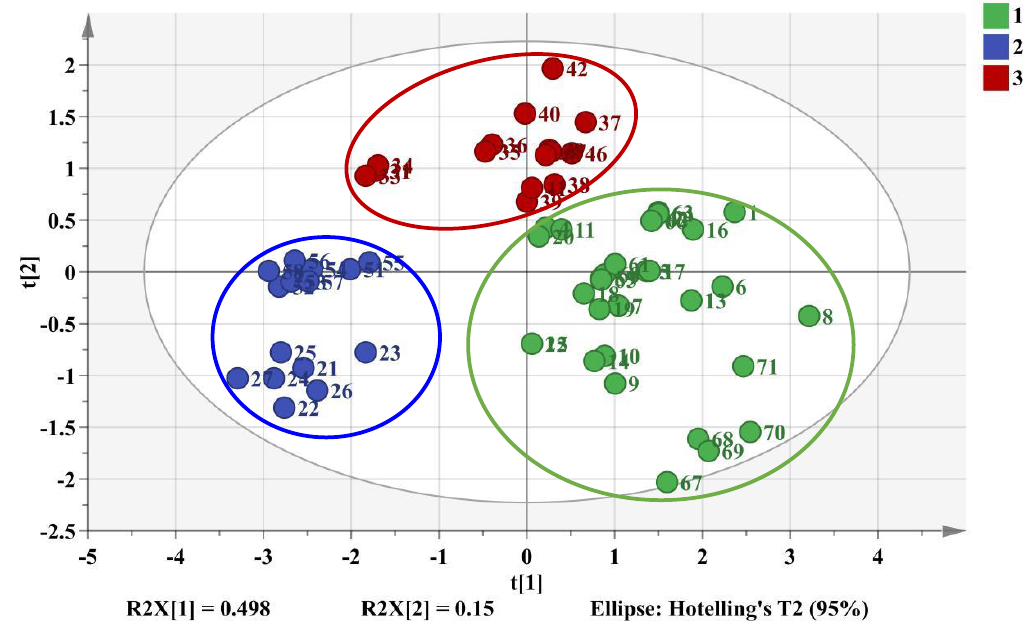
Figure 7. 2D PLS-DA score plot of training set samples and testing set samples. Cluster 1 (green color): cultivated M. bealei ; Cluster 2 (Blue color): wild M. bealei ; Cluster 3 (red color): substitutes.